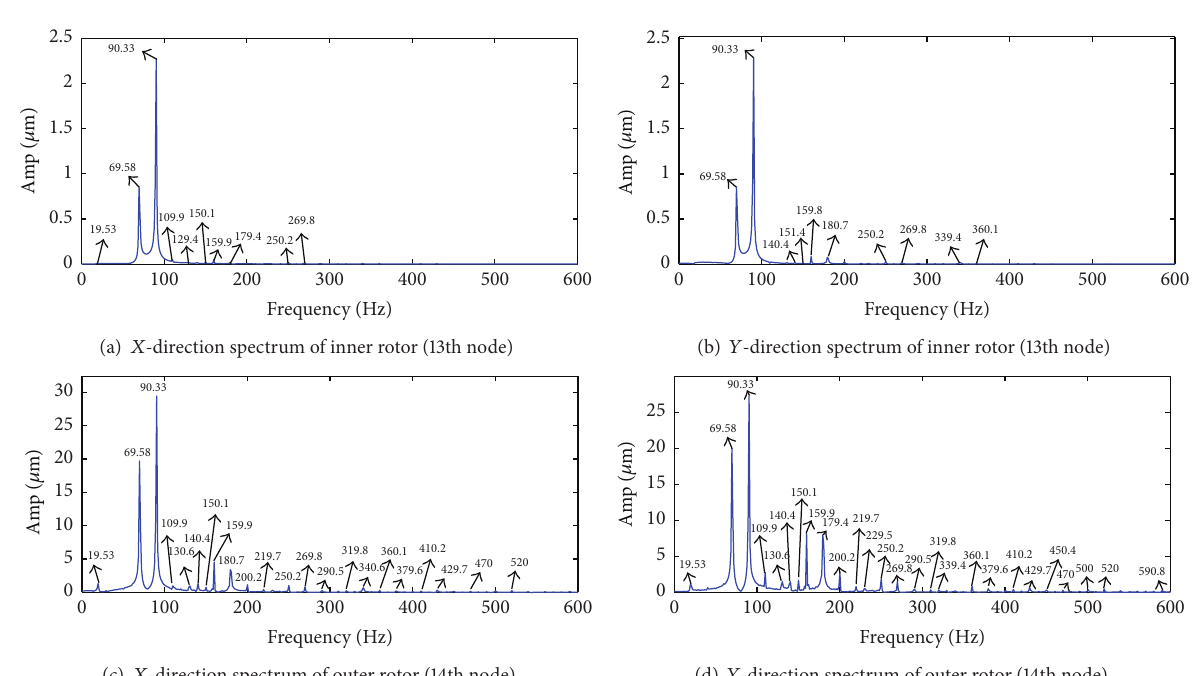
Figure 8: The vibration displacement spectrum of rotors (rubbing location: outer rotor